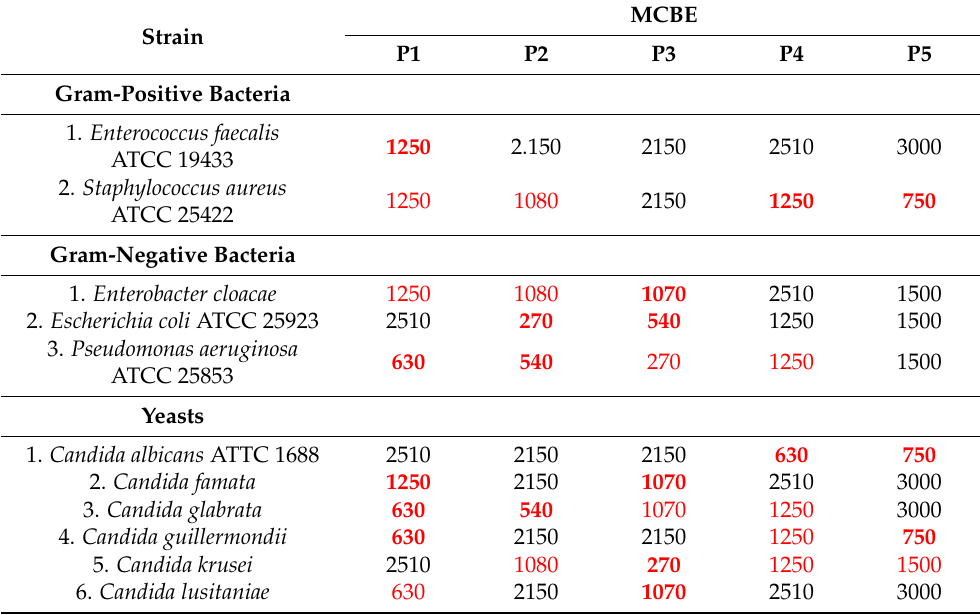
Table 8. Determination of minimal concentration for biofilm eradication (MCBE) values ( µ g/mL). Strain